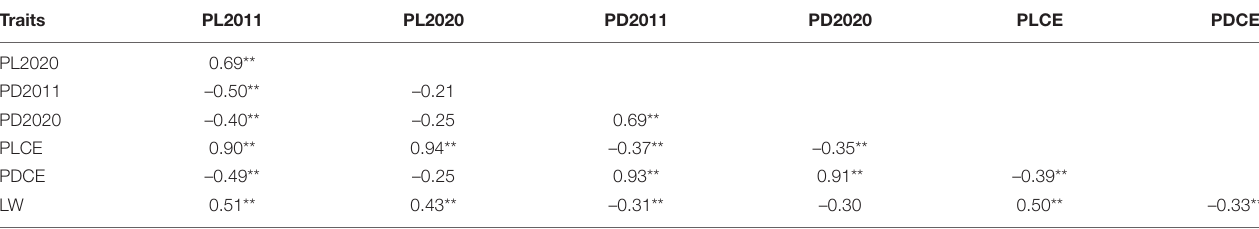
FIGURE 4 | Difference analysis of candidate genes of pubescence length (PL) and pubescence density (PD). (A,B) The expression levels of 21 and 12 candidate genes of PL (A) and PD (B) , respectively, in parents PI 342618B (black column) and NN 86-4 (yellow column). (C) DNA sequence alignment of the seventh exon of Glyma.01g240100 ( Pd1 ) in two parents. The yellow arrow represents the SNP between two parents. (D) Expression analysis of Glyma.12G187200 ( Ps ) in parents PI 342618B (black column) and NN 86-4 (yellow column) ( ∗ P ≤ 0.05; ∗∗ P ≤ 0.01). TABLE 5 | The correlation analysis of pubescence traits and resistance to CCW in four kinds of different pubescence morphology